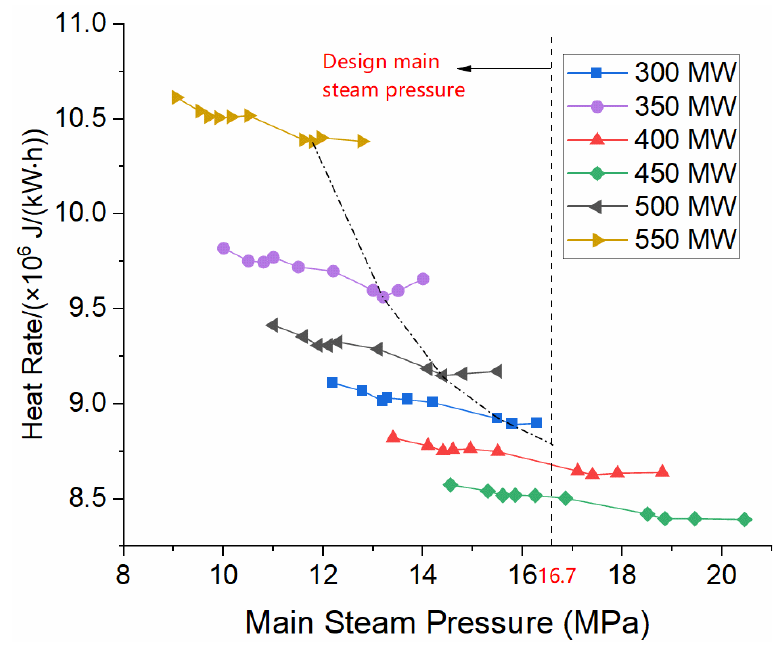
Figure 9. Heat rate vs. main steam pressure under different loads.